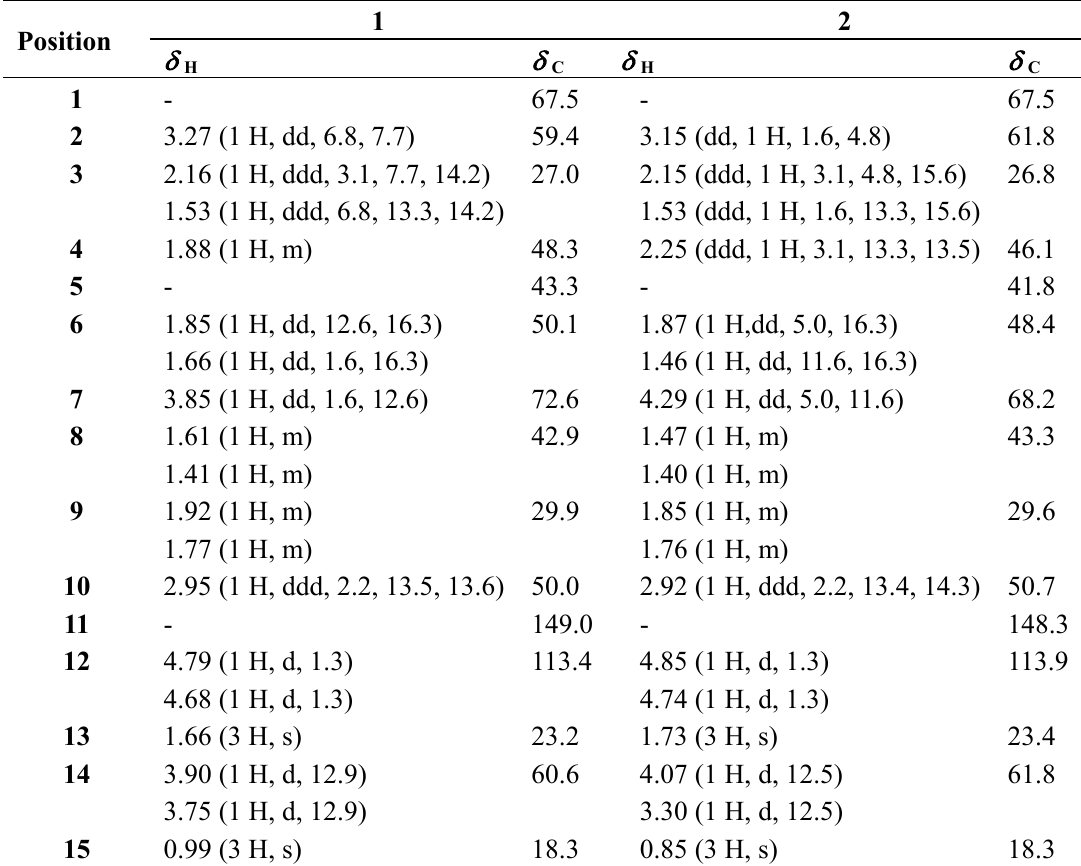
Table 1. NMR data of compounds 1 and 2 in CDCl ppm, J in